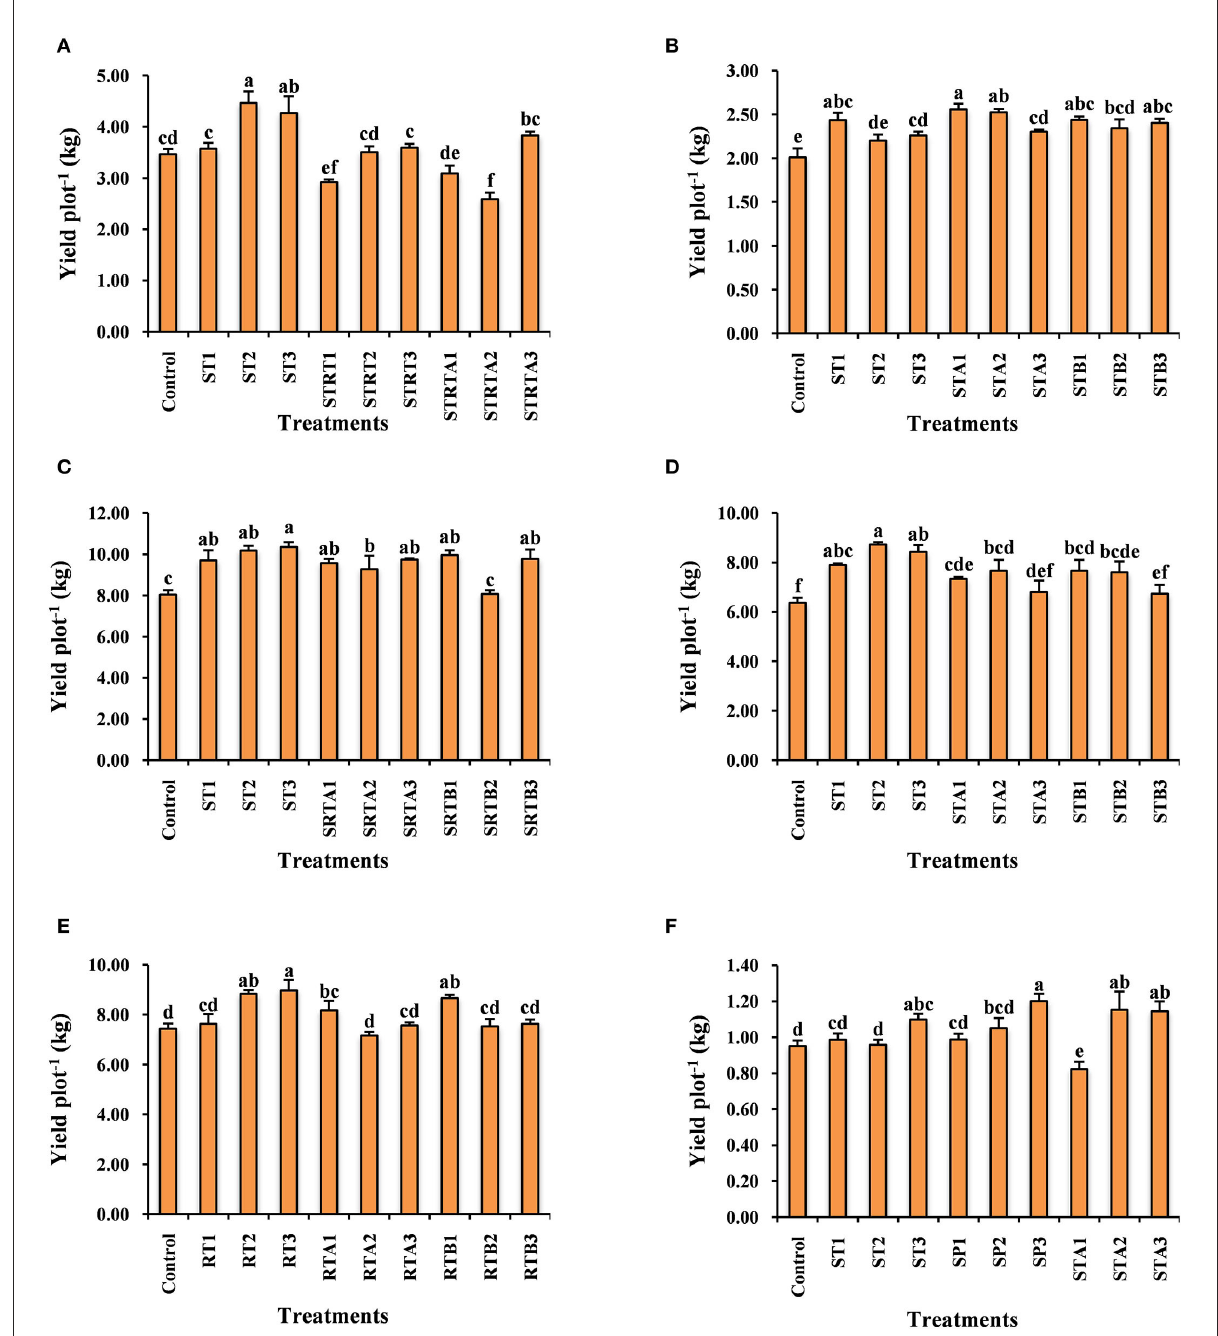
FIGURE2 Effect of calliterpenone on yield enhancement in rice (A) , wheat (B) , tomato (C) , potato (D) , onion (E) , and chickpea (F) . Statistical analysis was carried out taking means of three replicates; different letters above bars showed significant differences as compared to control through critical difference ( P ≤ 0.05). ST1, seed treatment with 0.1mM; ST2, seed treatment with 0.01mM; ST3, seed treatment with 0.001mM; STA1, seed treatment + 1 spray with 0.1mM; STA2, seed treatment + 1 spray with 0.01mM; STA3, seed treatment + 1 spray with 0.001mM; STB1, seed treatment + 2 spray with 0.1mM; STB2, seed treatment + 2 spray with 0.01mM; STB3, seed treatment + 2 spray with 0.001mM; SRT1, seed treatment + root treatment with 0.1mM; SRT2, seed treatment + root treatment with 0.01mM; SRT3, seed treatment + root treatment with 0.001mM; SRTA1, seed treatment + root treatment + 1 spray with 0.1mM; SRTA2, seed treatment + root treatment + 1 spray with 0.01mM; SRTA3, seed treatment + root treatment + 1 spray with 0.001mM; SRTB1, seed treatment + root treatment + 2 spray with 0.1mM; SRTB2, seed treatment + root treatment + 2 spray with 0.01mM; SRTB3, seed treatment + root treatment + 2 spray with 0.001mM; SP1, spray with 0.1mM; SP2, spray with 0.01mM; SP3, spray with 0.001mM; RT1, root treatment with 0.1mM; RT2, root treatment with 0.01mM; RT3, root treatment with 0.001mM; RTA1, root treatment + 1 spray with 0.1mM; RTA2, root treatment + 1 spray with 0.01mM; RTA3, root treatment + 1 spray with 0.001mM; RTB1, root treatment + 2 spray with 0.1mM; RTB2, root treatment + 2 spray with 0.01mM; RTB3, root treatment + 2 spray with